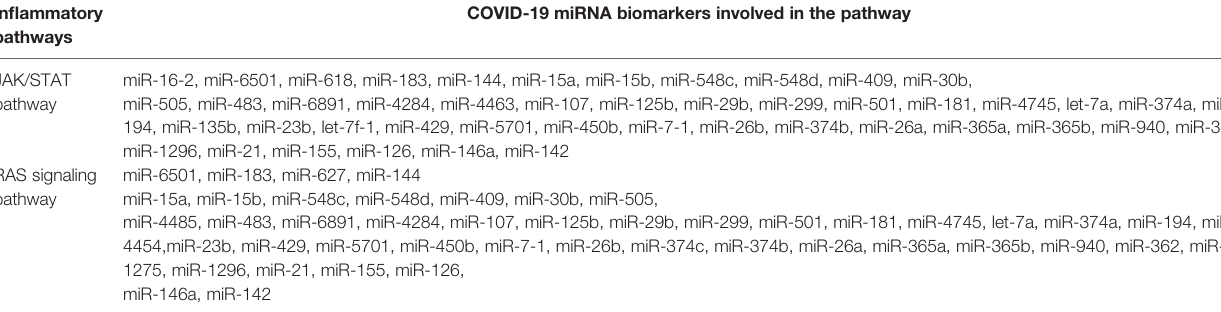
COVID-19 miRNA biomarkers involved in the pathway